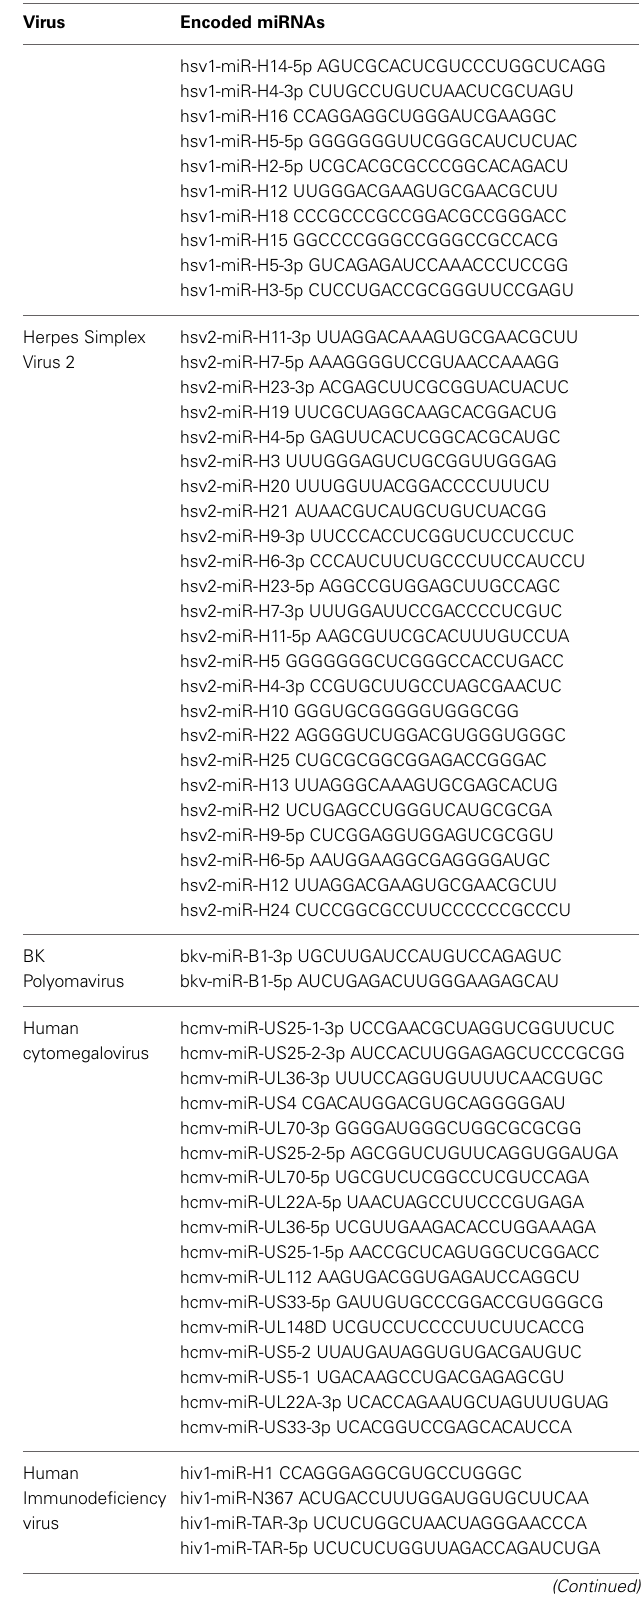
Table 1 | miRNAs encoded by viruses known to infect human. Virus Encoded miRNAs